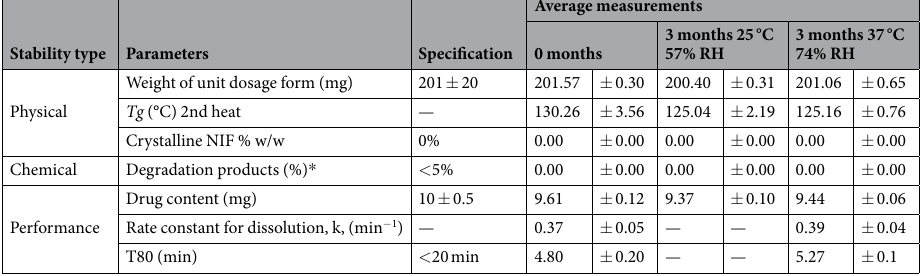
Table 1. Stability study summary for the in-situ freeze-dried capsule formulation, 10% w/w NIF in PVP. All data = averages ± SE of n = 6. * Degradation products include: 4-(2-nitrophenyl) pyridine homologue and 4-(2-nitrosophenyl)-pyridine